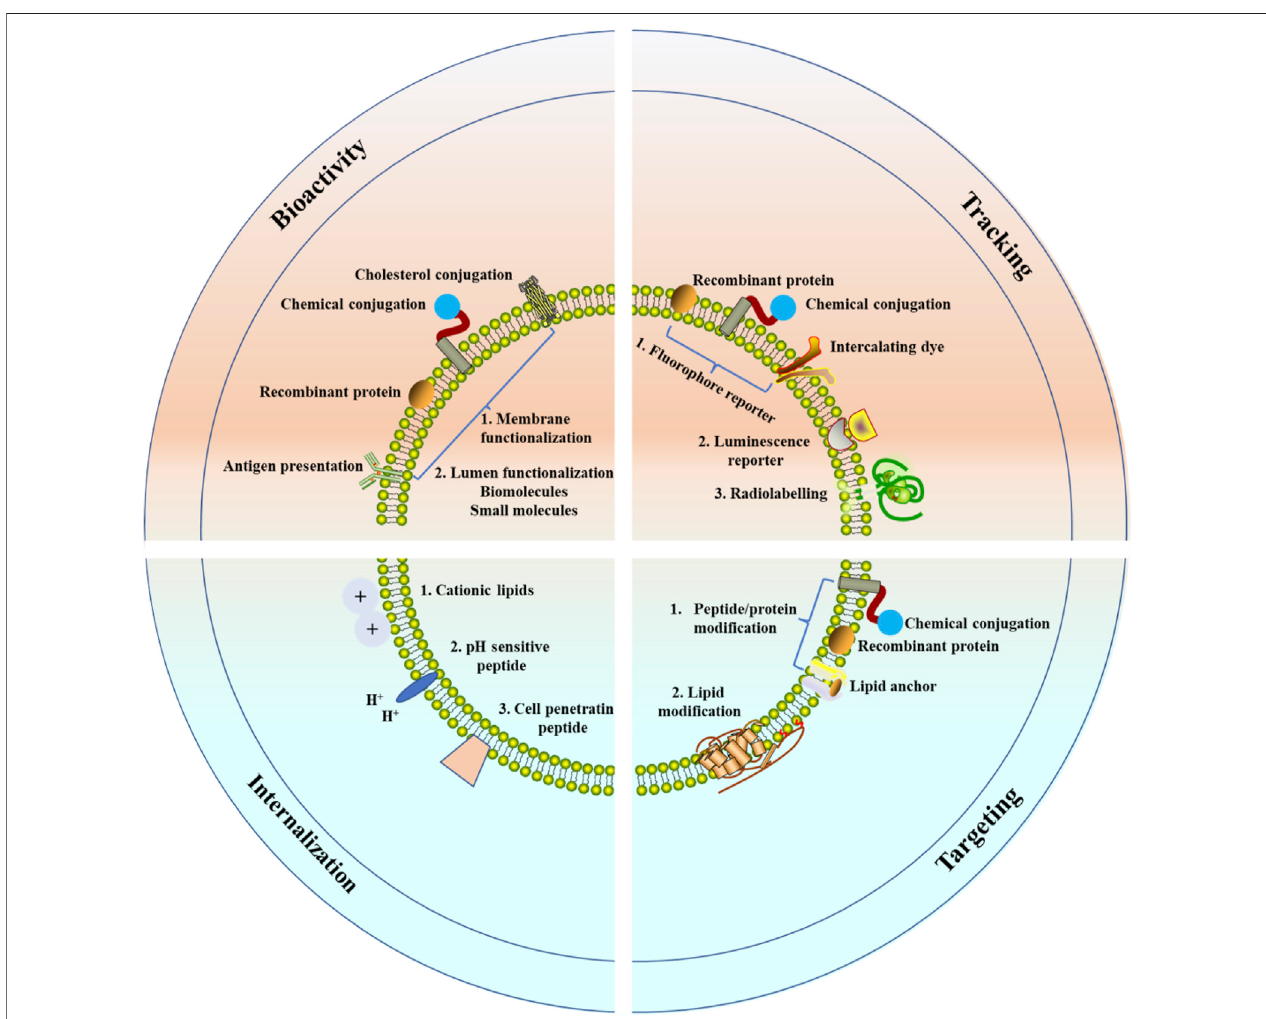
FIGURE4| ModulationofEVsforCVDstherapy.SeveralstrategieshavebeenusedtoovercomethelimitationsofnativeEVs.Toenhancethetherapeuticpotential of EVs, the membrane and the lumen have been functionalized. To track in vivo EVs, fl uorophores, luminescence reporters, or radiotracers have been used to label formulations. To improve the targeting ef fi cacy of EVs, exogenous peptides, proteins or lipids have been modi fi ed. To enhance EV internalization and endolysosomal escape, the vesicles have been modi fi ed with cationic lipids, pH-sensitive peptides, and cell-penetrating peptides.